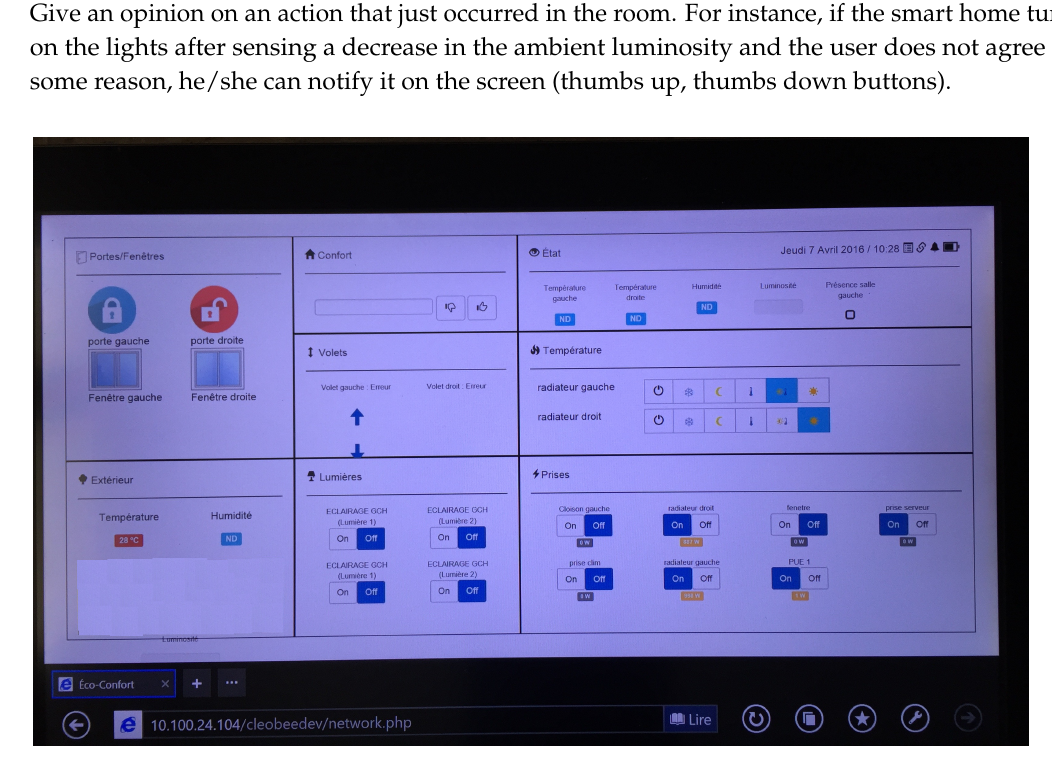
Figure 4. Ambient environment of Mines Douai—a web application shown through an interactive